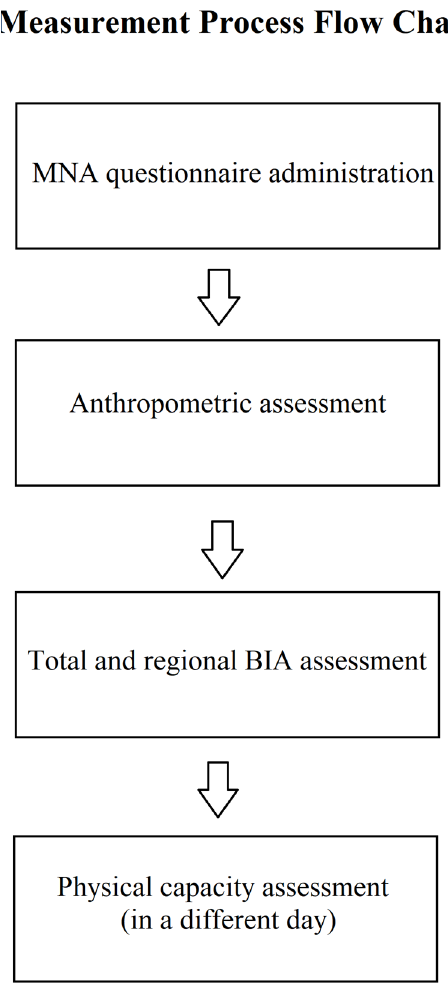
Figure 1. Measurement process flow chart.